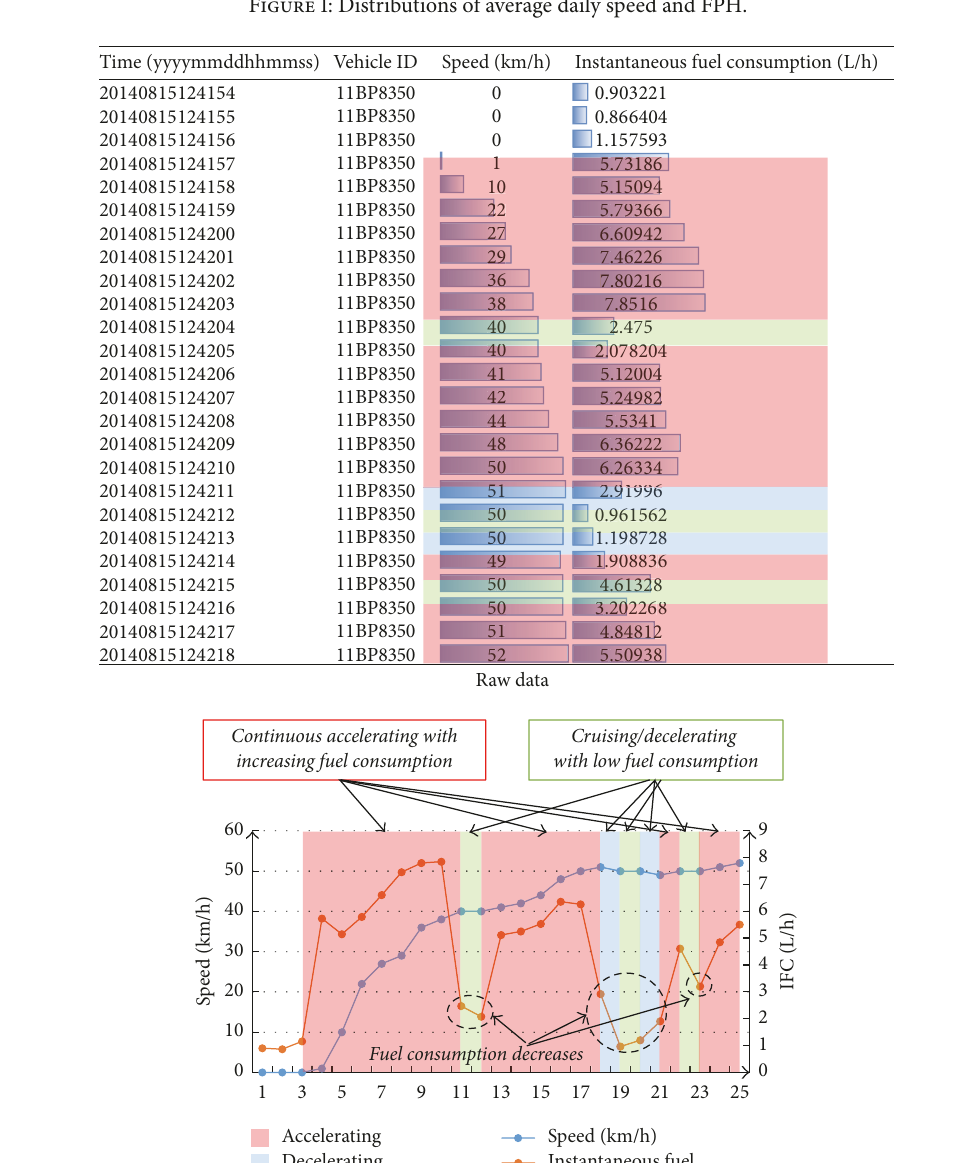
Figure 1: Distributions of average daily speed and FPH.